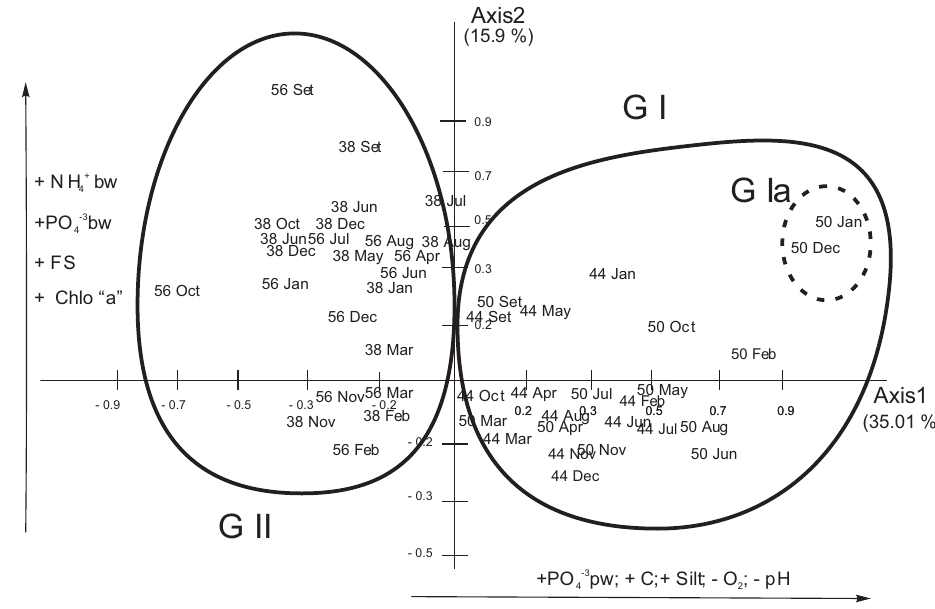
F IG . 5. – PCA ordination diagram of sampling based on the selected variables measured. The two main groups (Groups G I and G II) and the subgroup G Ia are